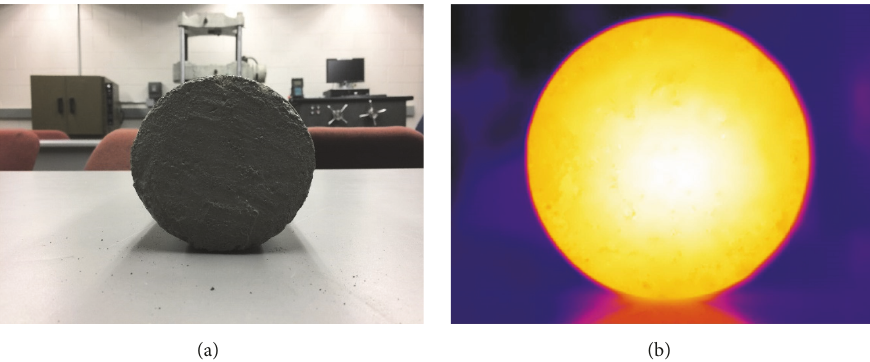
Figure 1: (a) Visual image of the specimen; (b) thermal image of specimen with defects that are inserted in the depth of 2 centimeters (heated up using heat